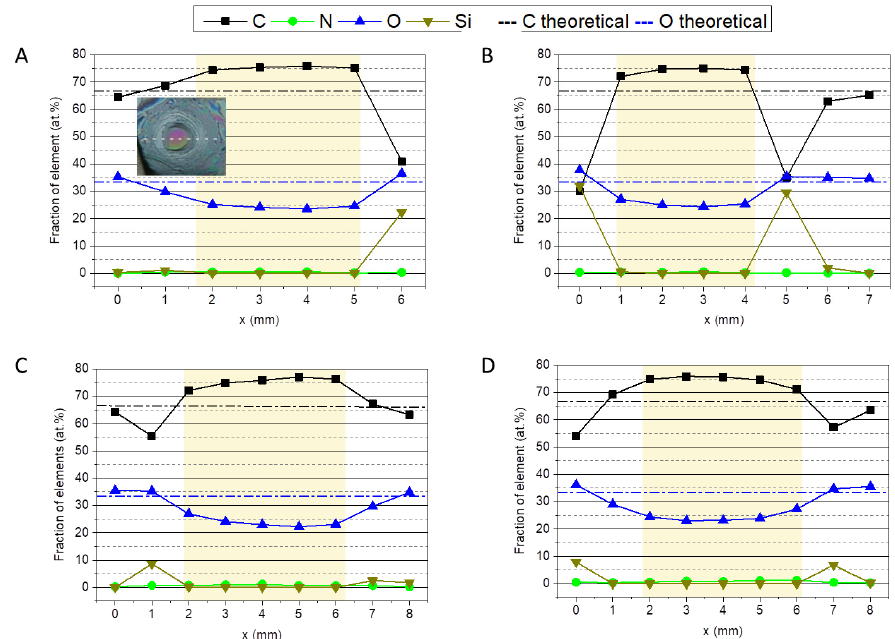
Figure 4. Line scan of the atomic percent concentrations of all elements identified on the sample surfaces S1 ( A ), S2 ( B ), S3 ( C ) and S4 ( D ). The dashed lines indicate the stoichiometric composition of Poly(2-hydroxyethyl methacrylate (PHEMA). The inset in Figure 4a presents a photograph of the generated coating. The yellow area highlights the center of the coating.